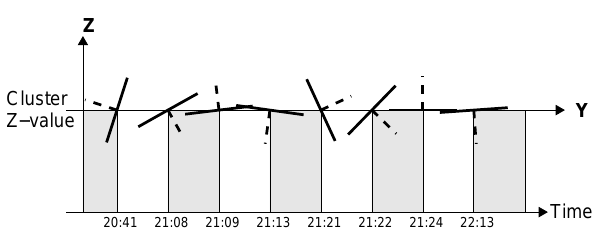
Fig. 16. YZ-plane of the plasma sheet boundary, shown as a fully drawn line, crossing the Cluster spacecraft constellation. The boundary normal is dashed, showing the direction in which the boundary moves past Cluster. Shaded areas indicate Cluster being inside the plasma sheet. Note that the time axis is not to scale. After 22:13 UT Cluster remains in the plasma